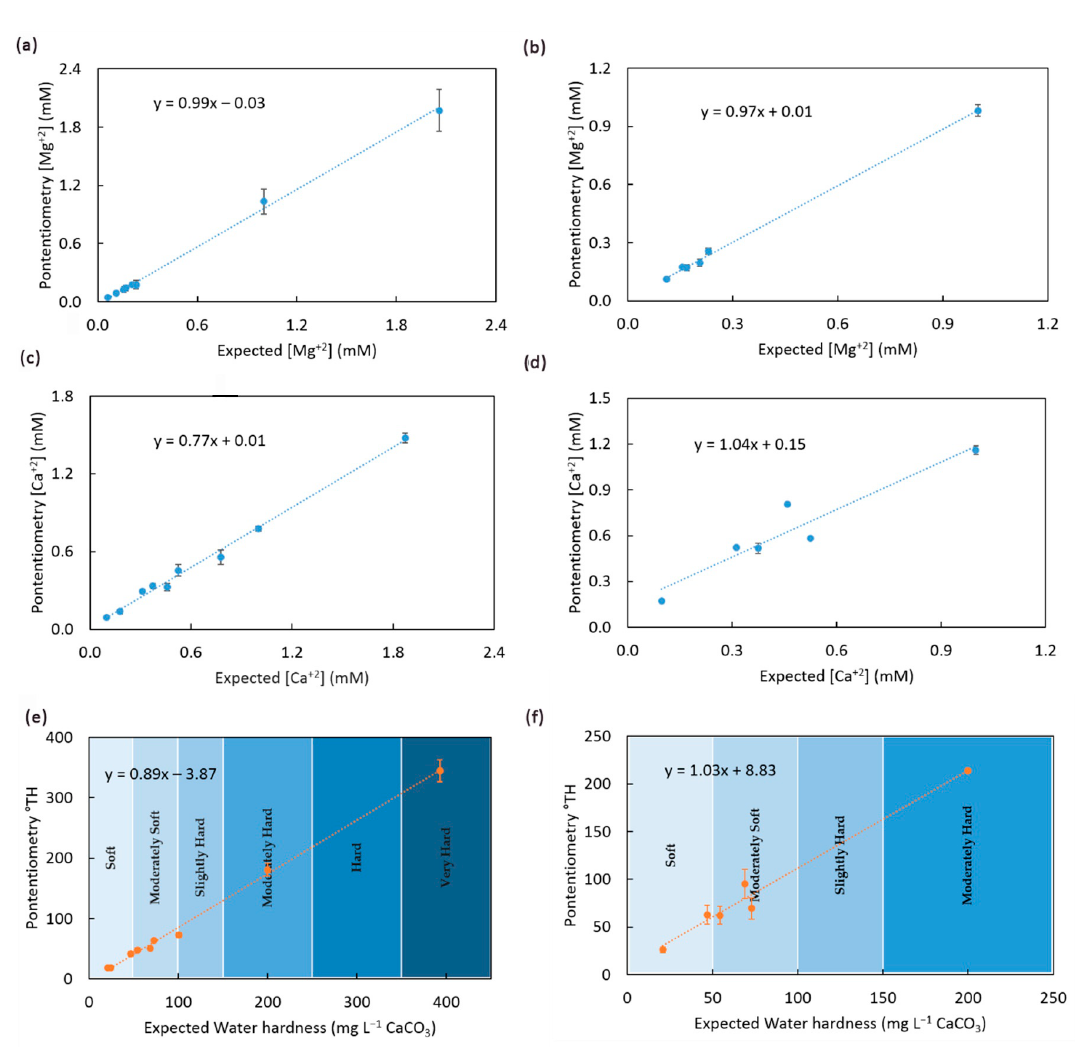
Figure 3. Prediction of magnesium and calcium concentration as well as hardness degree obtained from separate mea- surements ( a ): [Mg 2+ ], ( c ): [Ca 2+ ], ( e ): ◦ TH with 9 samples) and simultaneous measurement ( b ): [Mg 2+ ], ( d ): [Ca 2+ ], ( f ): ◦ TH with 6 samples) N = 3. Measured ◦ TH were obtained from potentiometry and expected ◦ TH values were given by weighted